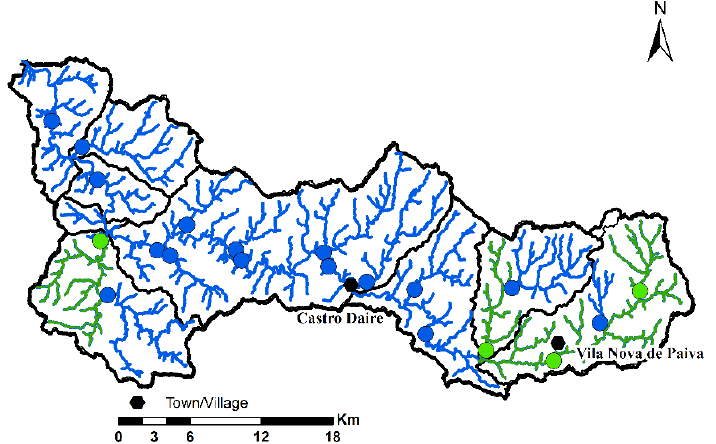
Figure 9. Ecological status of the Paiva River catchment according to IPtI N (Blu—excellent quality, Green—Good quality).